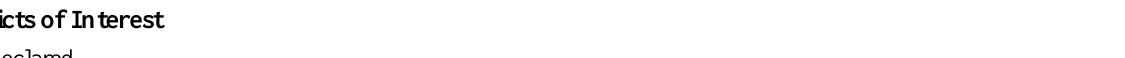
Mean score (scored from 1-5, where 1=disagree and